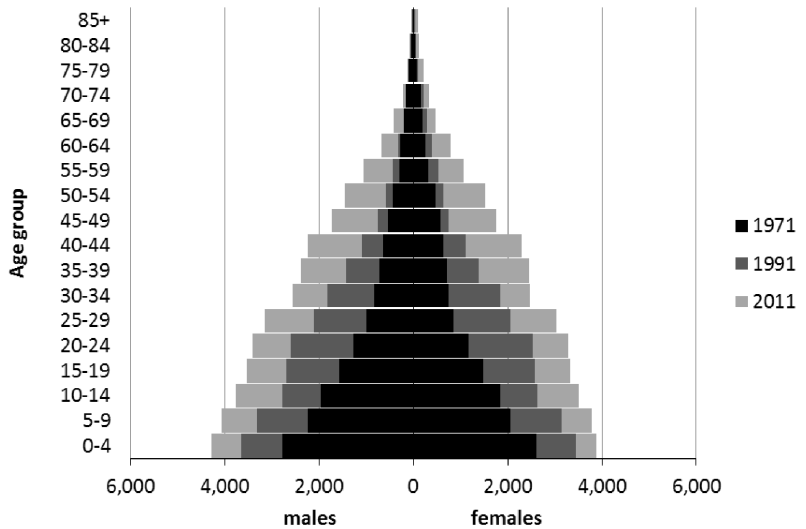
Figure 7. The age-sex structure of the Northern Territory Indigenous population, 1971, 1991 and 2011.